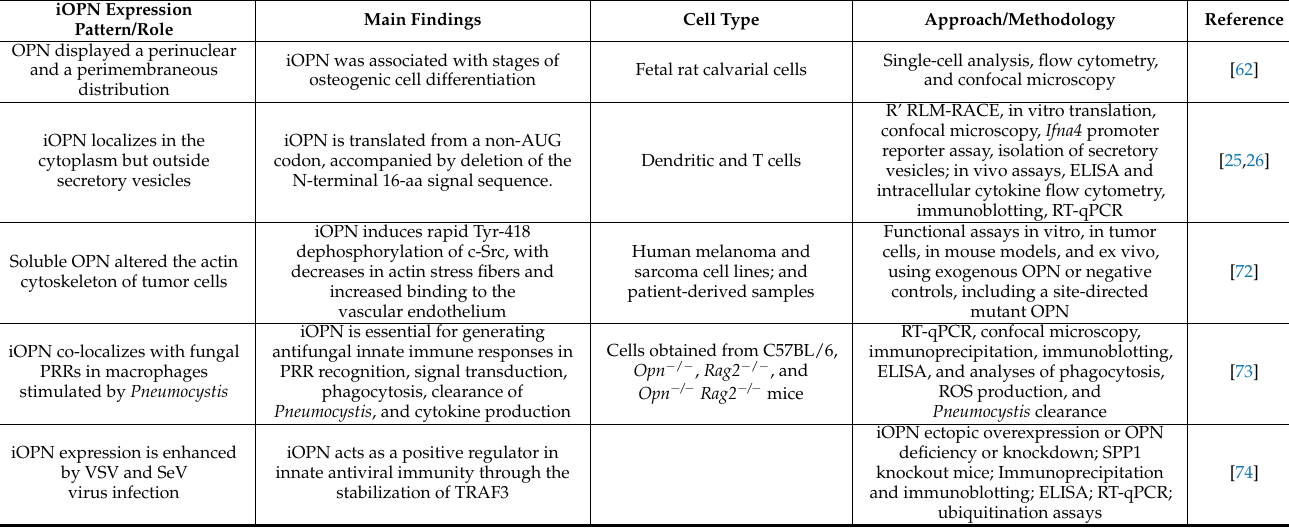
Table 2. Main current findings regarding iOPN and associated